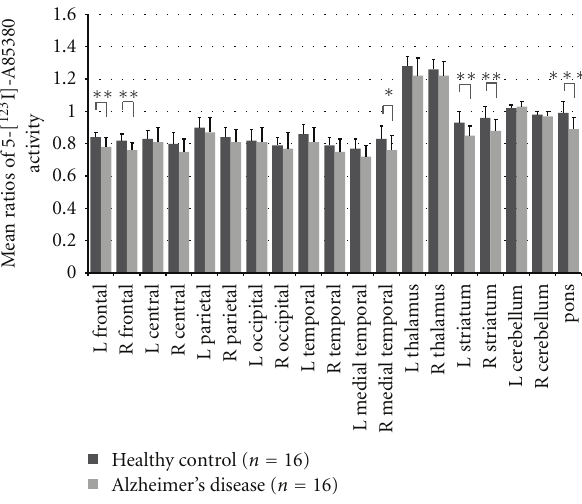
Figure 3: Comparison with regional uptake values of 5- [ 123 I]I-A85380 in age-matched healthy control and patients with Alzheimer’s disease. Significant bilateral reductions in nicotinic receptor binding were identified in frontal, striatal, right medial temporal, and pons in patients with AD compared to controls. (Data is from the paper of O’Brien et al. [59].) ∗ P < . 05, ∗∗ P < . 005, ∗∗∗ P < .